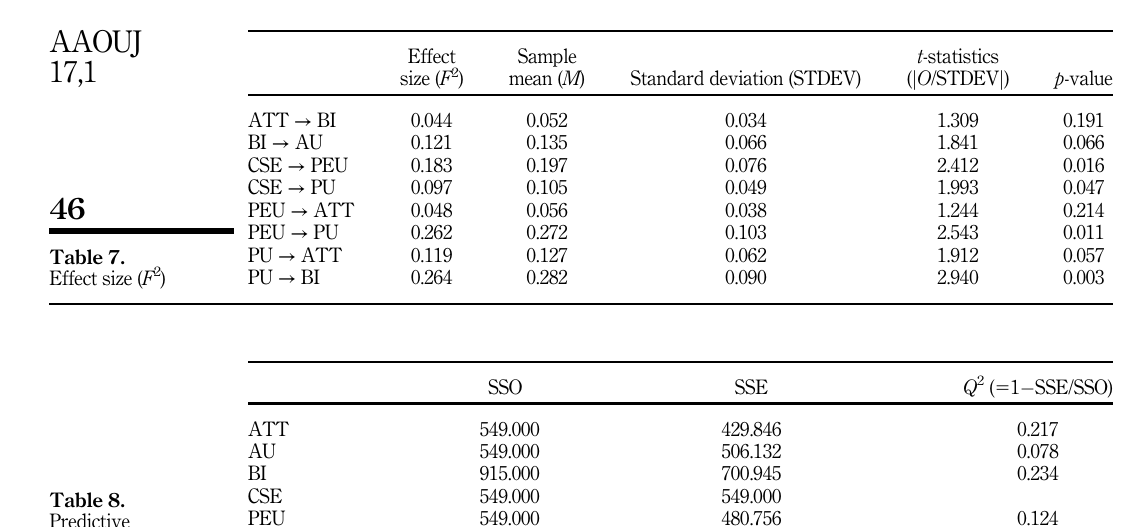
Table 8. Predictive relevance ( Q 2 )